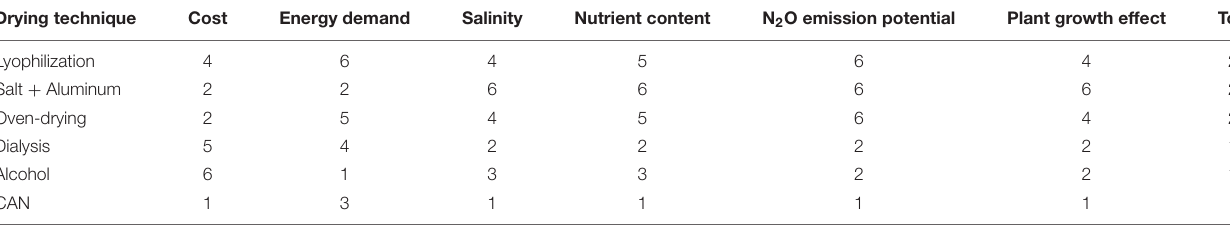
TABLE 5 | Decision matrix, comparing various jellyfish drying techniques with CAN fertilizers. Drying technique Cost Energy demand Salinity Nutrient